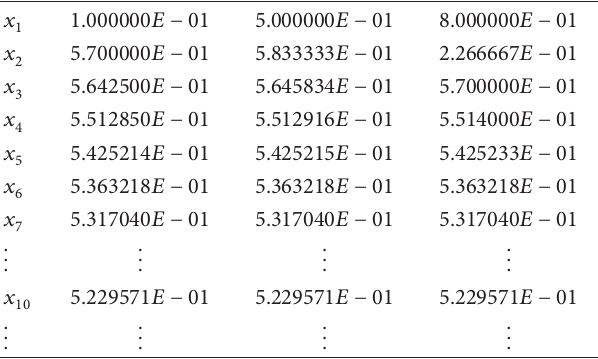
Table 1: The numerical results are obtained by using FORTRAN90 Programming